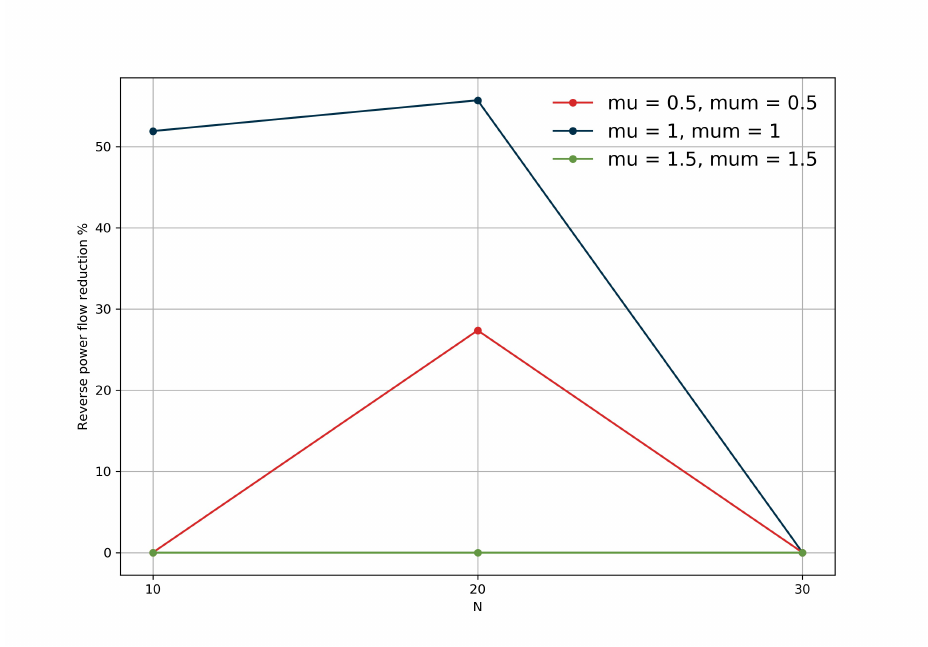
Figure 6. Reverse Power Flow (RPF) % evolution according to population size, crossover and mutation rates.